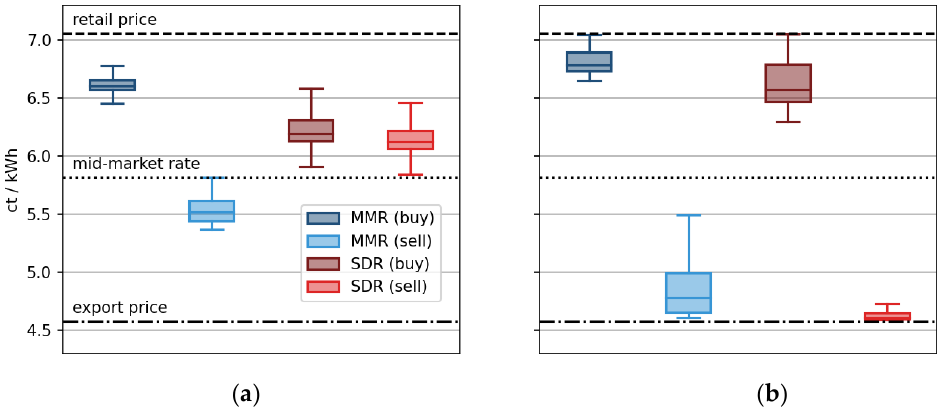
Figure 17. Distribution of annual average P2P prices of all German municipalities ( n = 11,977). Actual prices are shown in ( a ) while weighted prices are displayed in ( b ). The prices in ( b ) have been weighted per hour according to the current demand (buy prices) or supply (sell prices).